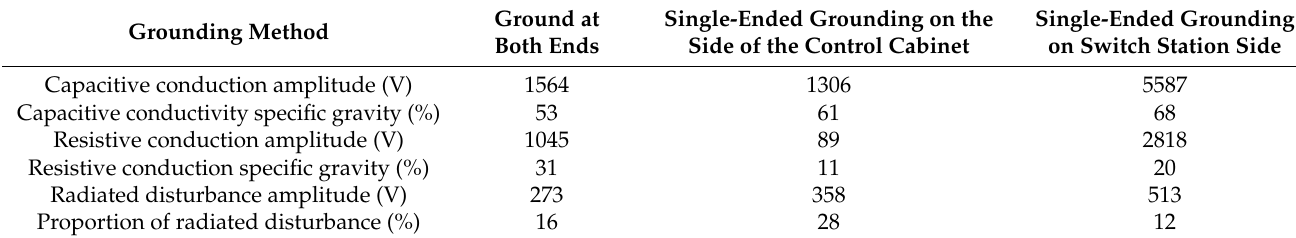
Table 5. Variation of disturbance voltage under different grounding